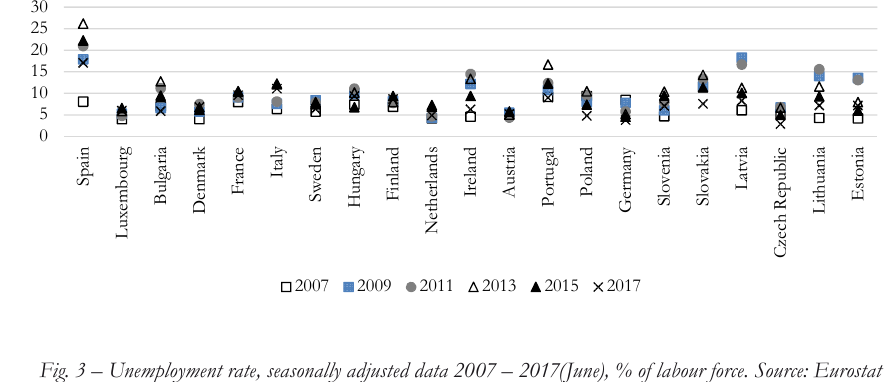
Fig. 3 – Unemployment rate, seasonally adjusted data 2007 – 2017(June), % of labour force. Source: Eurostat